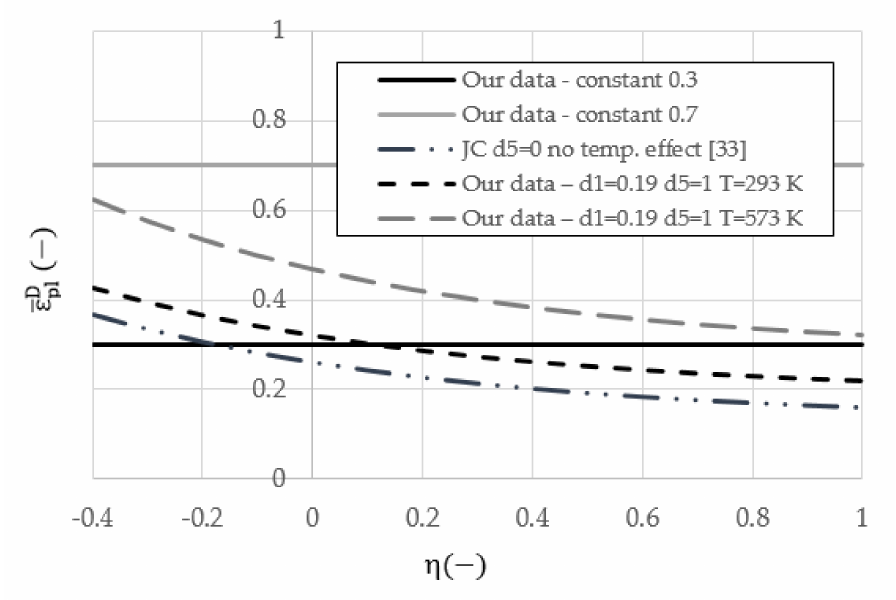
Figure 5. The considered initiation damage criteria for the 2024-T3 aluminum alloy as a func- tion of triaxiality η for two different temperatures and strain rate 1.0 l/s; (-) stands for a dimensionless